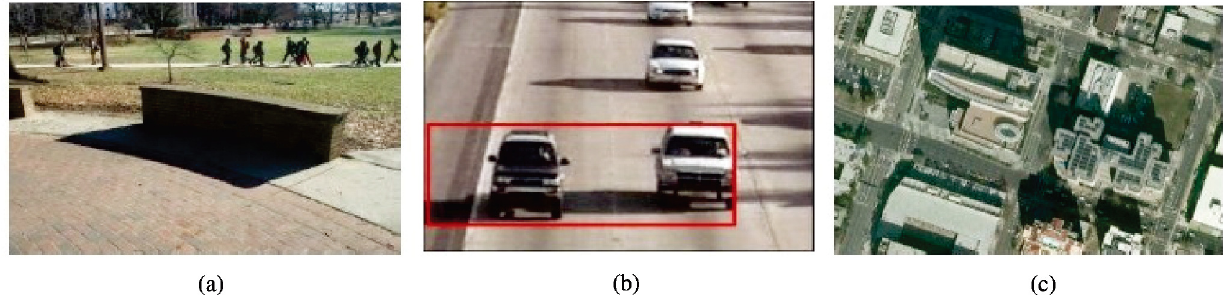
Fig. 1 Shadows causing problems in (a) object detection, (b) traffic monitoring, and (c) interpretation of remote-sensing images.